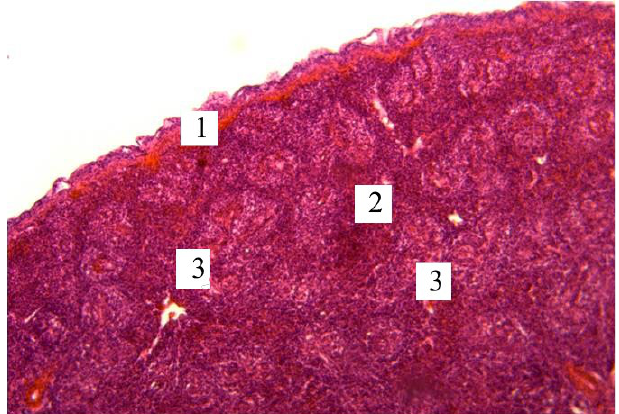
Fig. 4 . Microscopic structure of the spleen of a 50-day- old vaccinated chicken: 1 – capsule; 2 – red pulp; 3 – white pulp. Hematoxylin and eosin. x 100.